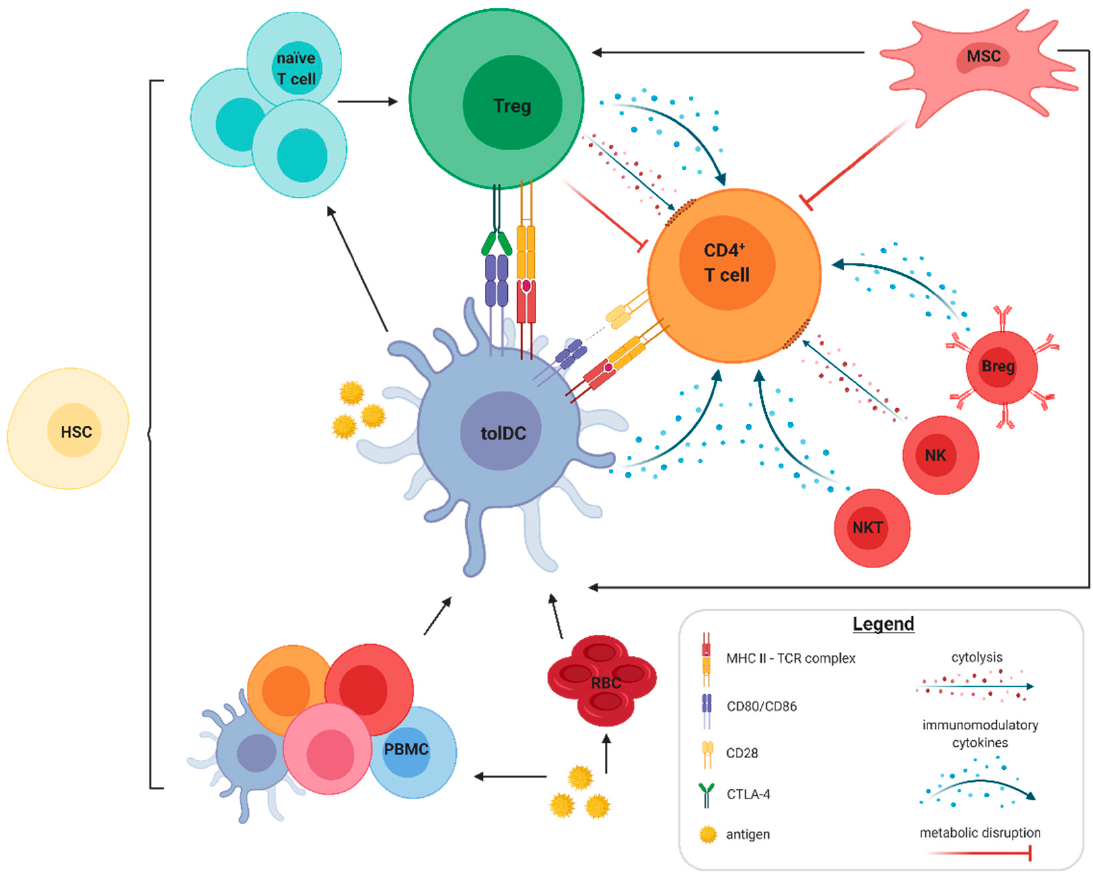
Figure 1. Autologous cell-based tolerance-inducing treatments in multiple sclerosis (MS). This schematic overview depicts the various modes of action implemented by cell-based tolerance-inducing treatments in MS. Additionally shown are the indirect tolerance-inducing strategies by means of inducing a regulatory phenotype in naïve T cells or by peptide-coupled fixed peripheral blood mononuclear cells and erythrocytes. Tolerance induction results in cytolysis, alteration in immune function and/or metabolic disruption of the target autoreactive T cells. The black arrows represent the functional influence. Abbreviations used: Breg: regulatory B cells; CTLA-4: cytotoxic T lymphocyte-associated antigen 4; HSC: haemopoietic stem cells; MHC: major histocompatibility complex; MSC: mesenchymal stromal cells; NKT: natural killer T cells; NK: natural killer cells; PBMC: peripheral blood mononuclear cells; RBC: erythrocytes; Treg: regulatory T cells; TCR: T cell receptor; tolDC: tolerogenic dendritic cells. Created with BioRender.com, accessed date 13 July 2021 .